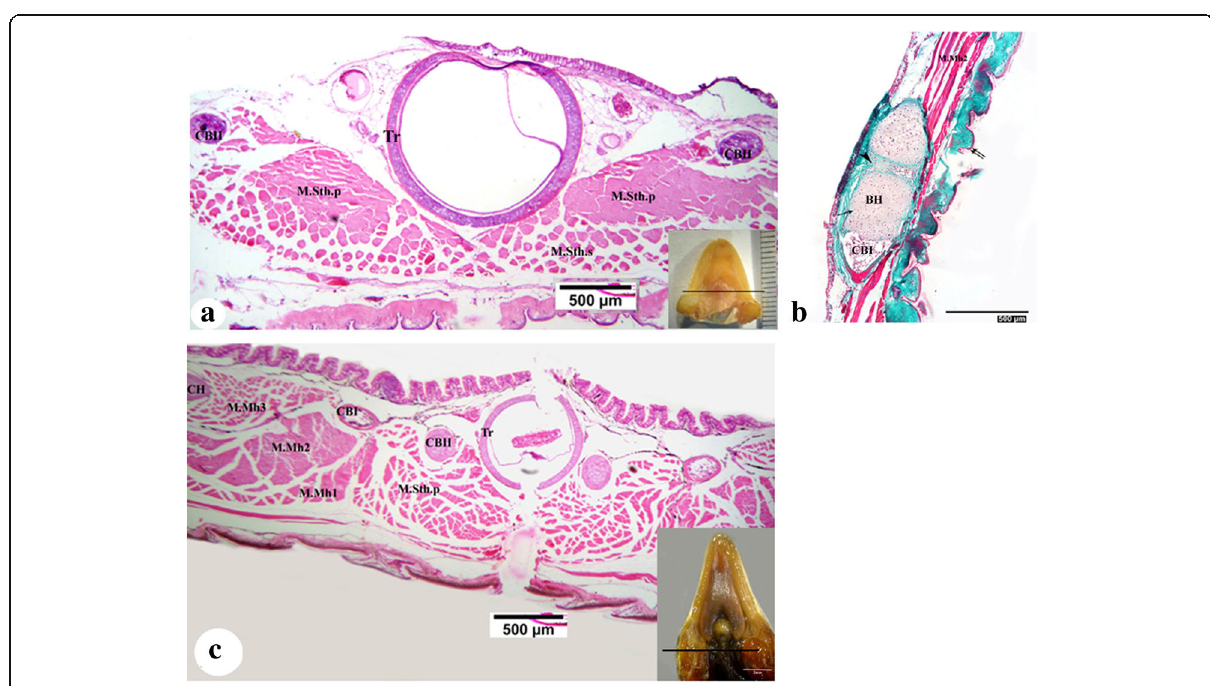
Fig. 4 Photomicrograph of a transverse section and b longitudinal section through the posterior portion of the tongue of P. guttatus showing the second ceratobranchialis (CBII), trachea (Tr), and synochrosis articulation between basihyoid and ceratobranchialis (CBI) through basi-ceratobranchialis ligament (arrowhead) and ventral epithelium (double arrows). c Photomicrograph of transverse section through the most posterior portion of the tongue of A. boskianus showing the attachment sites of the muscle mandibulohyoideus 1(M.mh1), muscle mandibulohyoideus 2 (M.mh2), muscle mandibulohyoideus